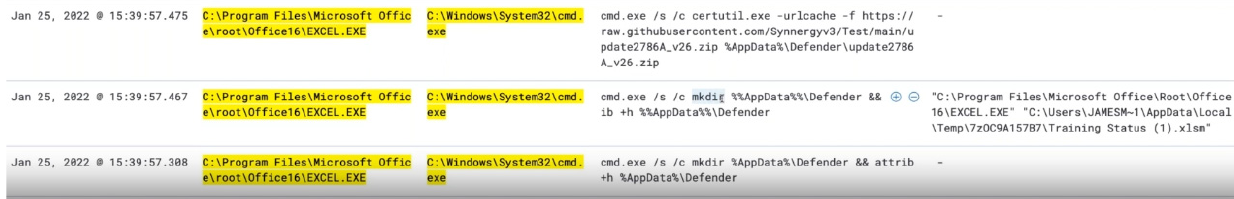
Figure 8. Filtering for process variables.